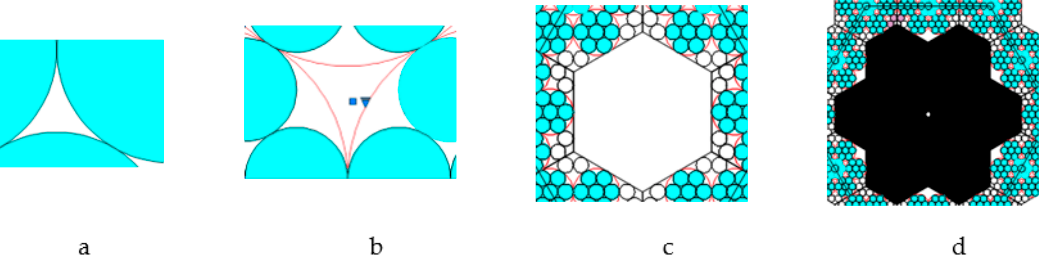
Figure 11. Four pore types: ( a ) type one; ( b ) type two; ( c ) type three; ( d ) type four.